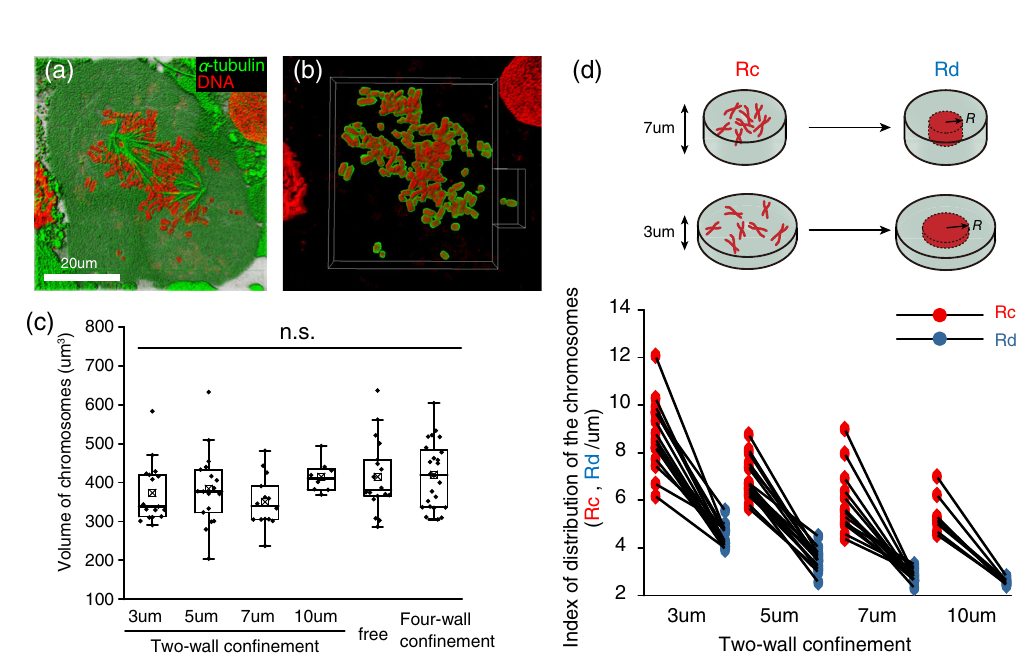
FIG. 8. Two-wall confinement resulting in scattered distribution of chromosomes. (a,b) Discernment of chromosomes by I mage J . (c) Chromosome volume under two-wall confinement ( n ¼ 17 , 18, 14, 8), no confinement ( n ¼ 18 ), and four-wall confinement ( n ¼ 24 ). We use Mood ’ s median test; n.s., not significant; p ¼ 0 . 13167 . (d) Difference between R c and R d still increasing as the height of two-wall confinement decreases ( n ¼ 17 , 18, 14,